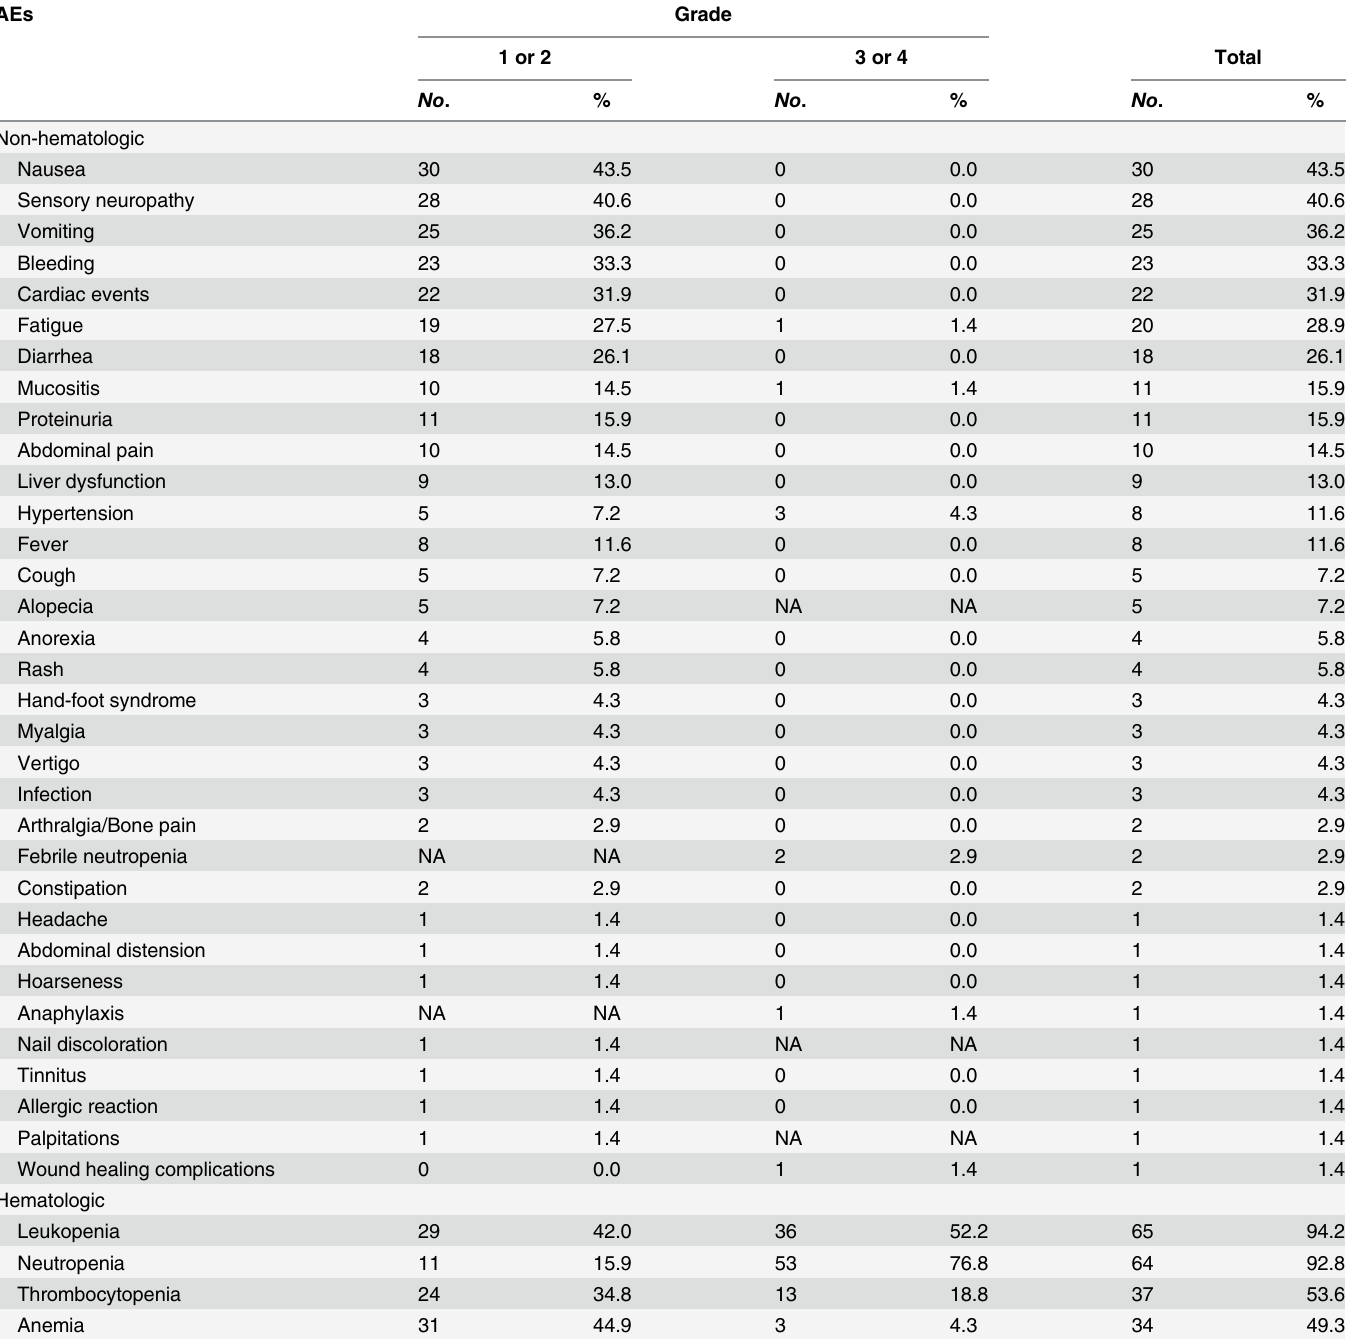
Table 2. AEs ( N = 69). Note: This table included AEs occurring between the date of the first dose and 30 days following the last dose of study treatment. Abbreviations: AEs, adverse events; NA, not